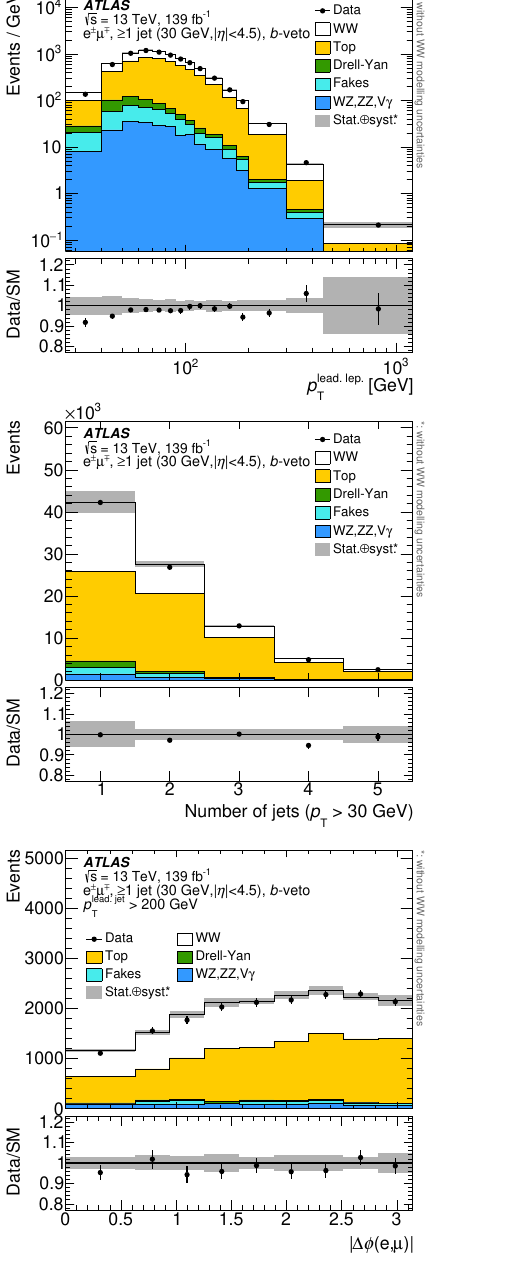
Figure 3 . Signal region detector-level distributions of the p lead. lep. right), the jet multiplicity (middle left), the m 200 GeV, the ∆ φ ( e, µ ) (bottom left) and m together with the predictions for the signal and background production processes. The last bin contains overflow events. The lower panels show the ratio of the data to the total prediction. The uncertainty bands shown include statistical and systematic uncertainties, excluding theory uncertainties on the